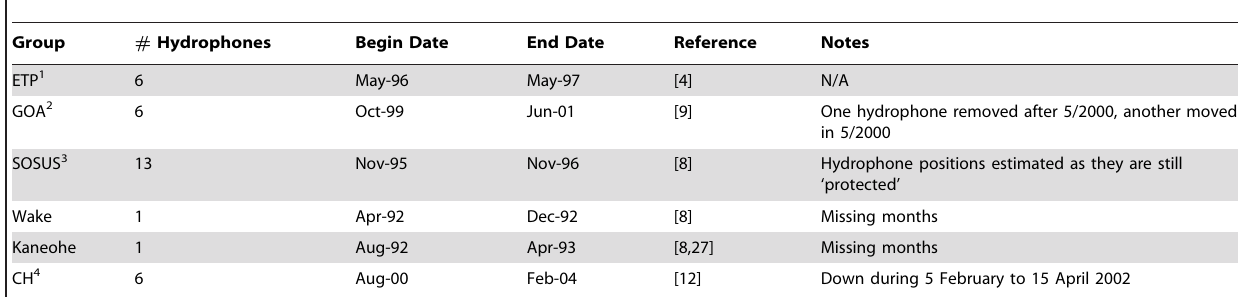
Table 2. Summary of the groups of acoustic hydrophones used in this study.